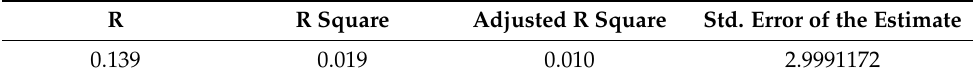
Table 7. Fitness of the multiple variable regression. R R Square Adjusted R Square Std. Error of the Estimate 0.139